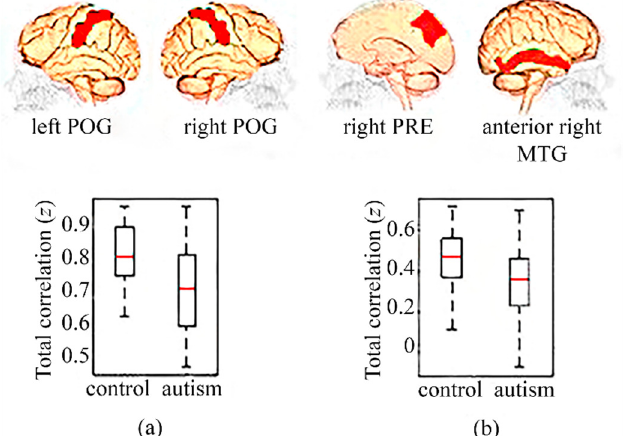
Figure 3. Hypoconnectivities in adolescents (12–18 years old) with autism relative to controls in a multicenter study. ( a ) Boxplot showing full correlation Fisher’s z values between left and right POG in controls and autists; ( b ) Boxplot showing the full correlation Fisher’s z values between the right PRE and anterior right MTG present in controls and autists. MTG: middle temporal gyrus; POG: postcentral gyrus; PRE: precuneus.